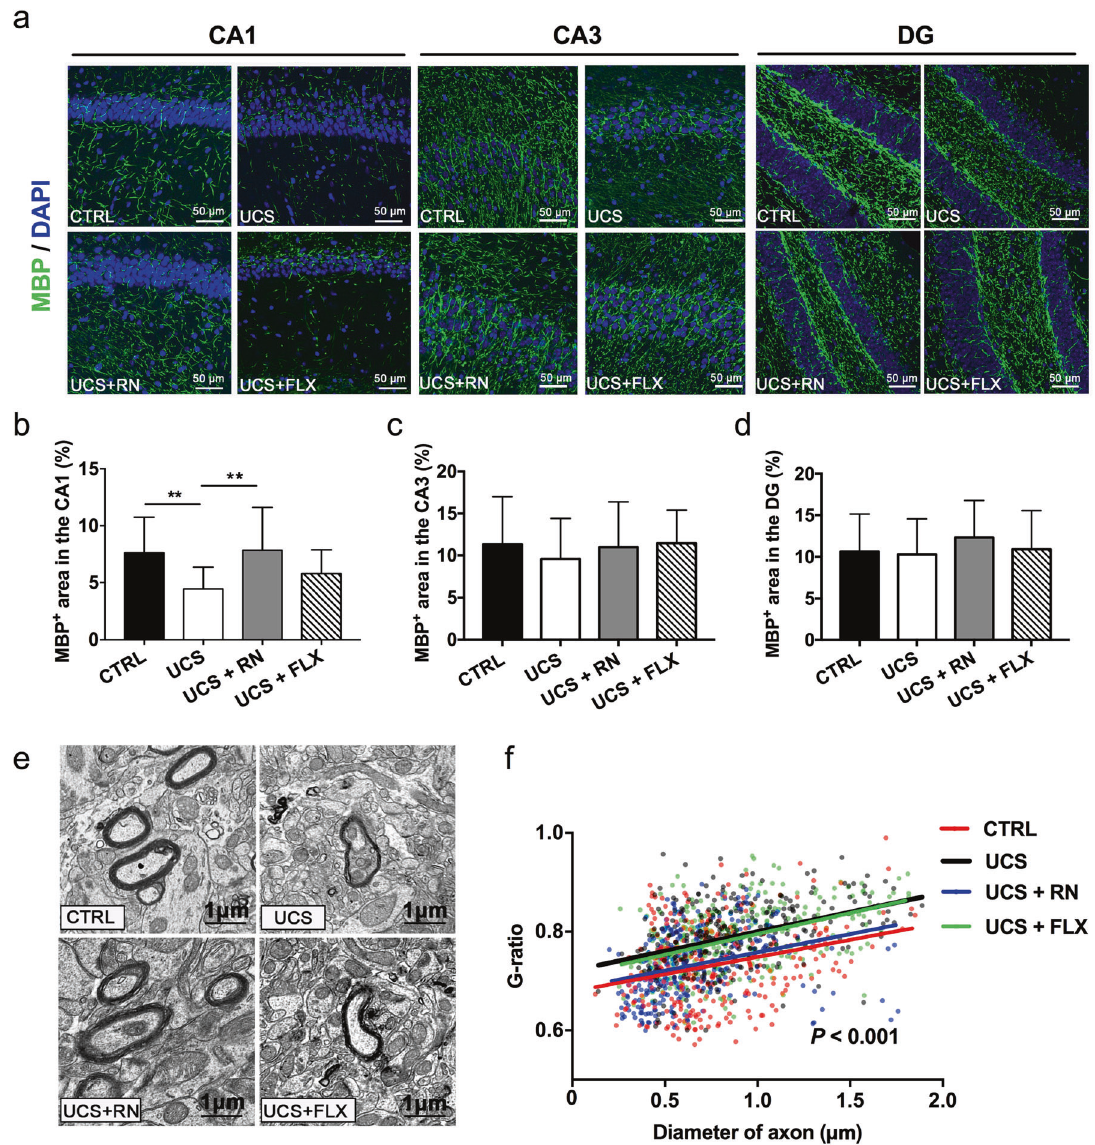
50 μ m. b – d Immuno fl uorescence analyses of MBP + (green) myelinated fi bers in the CA1, CA3, and DG hippocampal sub fi elds of mice in the CTRL group, UCS group, UCS + RN group, and UCS + FLX group ( n = 5 for each group). e Electron micrographs of axons in the CA1 hippocampal sub fi eld of mice in the CTRL group, UCS group, UCS + RN group, and UCS + FLX group. Scale bar = 1 μ m. f Quanti fi cation of the myelin sheath thickness (G-ratio) in the CA1 sub fi eld of mice in the CTRL group ( n = 303 axons from four mice), UCS group ( n = 316 axons from four mice), UCS + RN group ( n = 332 axons from four mice), and UCS + FLX group ( n = 310 axons from four mice). All data are shown as the means ± SDs. * P < 0.05 and ** P <